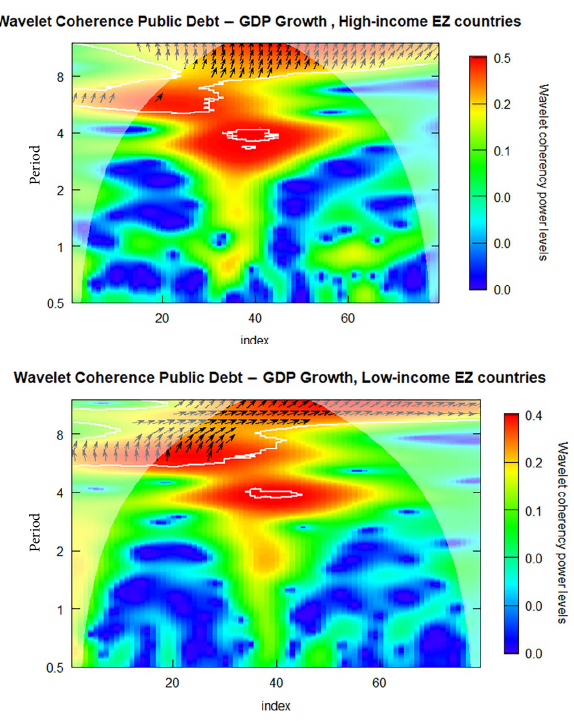
Figure 4. Wavelet coherence public debt-GDP growth for high-income Euro Zone countries and low-income Euro Zone